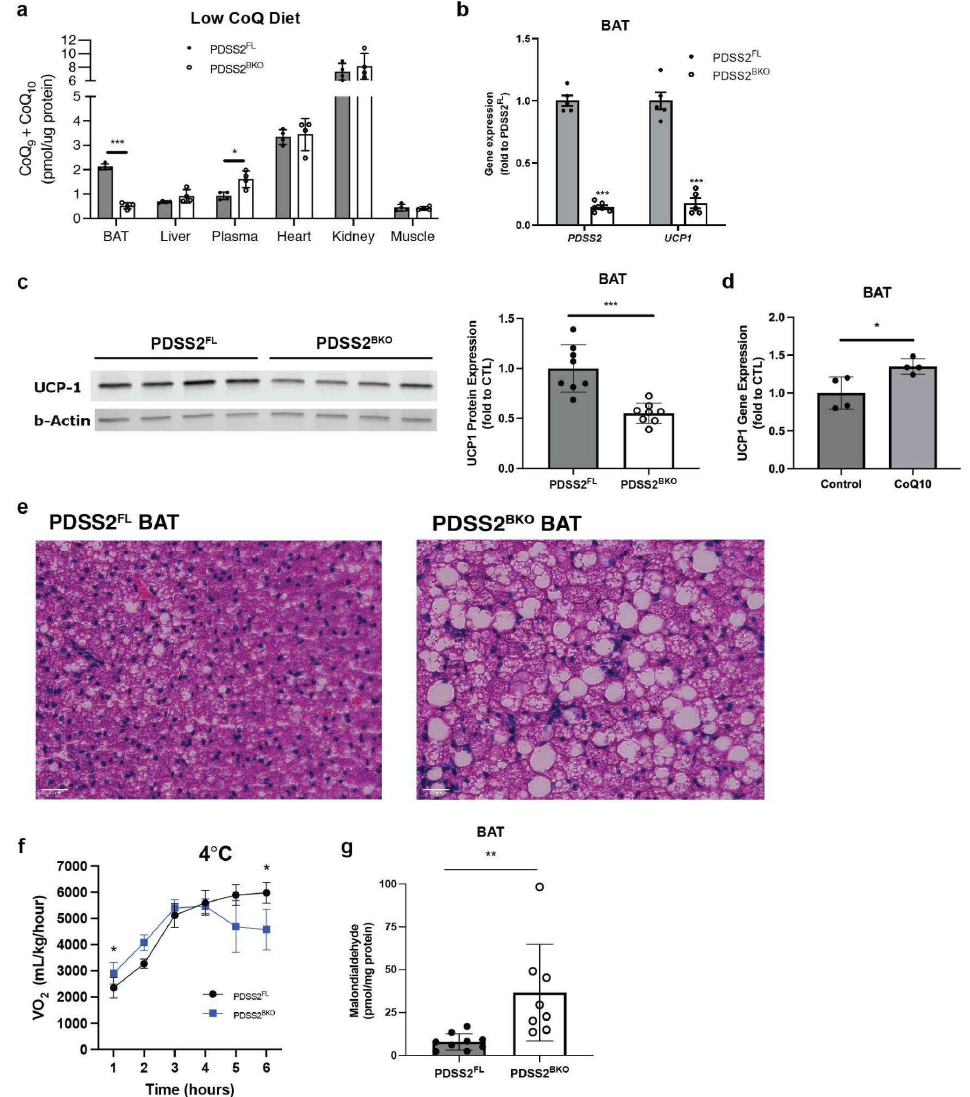
Figure 4. CoQ deficiency leads to BAT dysfunction in vivo. ( a ) CoQ levels in BAT of BAT-specific PDSS2 knockout mice (PDSS2 BKO ) were decreased compared to controls (PDSS2 FL ) when mice were fed a defined low CoQ diet. CoQ levels in other tissues and plasma were also measured, n = 4. ( b ) PDSS2 and UCP1 gene expression, measured by rtPCR, in BAT was decreased in PDSS2 BKO compared to PDSS2 FL , n = 5–6. ( c ) UCP1 protein levels in BAT from knockout mice compared to control mice were decreased when assessed and quantified using western blot, n = 8. Each lane in the western blot pictured is one independent sample. ( d ) UCP1 gene expression was measured from BAT of wildtype mice fed a defined low CoQ diet with or without a CoQ 10 supplement. CoQ 10 supplementation to the diet increased UCP1 gene expression, n = 4. ( e ) Hematoxylin & Eosin (H&E) staining of BAT from PDSS2 FL and PDSS2 BKO animals, scale bar = 25 μm. BAT from PDSS2 BKO animals presents a whitening phenotype compared to BAT from PDSS2 FL . ( f ) Oxygen consumption of PDSS2 FL and PDSS2 BKO animals at 4 °C, measured by Comprehensive Lab Animal Monitoring System (CLAMS) (n = 3/group), showed increased cold sensitivity in PDSS2 BKO animals. ( g ) Lipid peroxidation products malondialdehyde (MDA), measured using a TBARS assay (KGE013, R&D), was increased in BAT from knockout mice compared to controls, n = 8–9. Data represent mean ± SEM. Significance presented at * p < 0.05, ** p < 0.01, and *** p < 0.001 compared to controls or otherwise indicated.